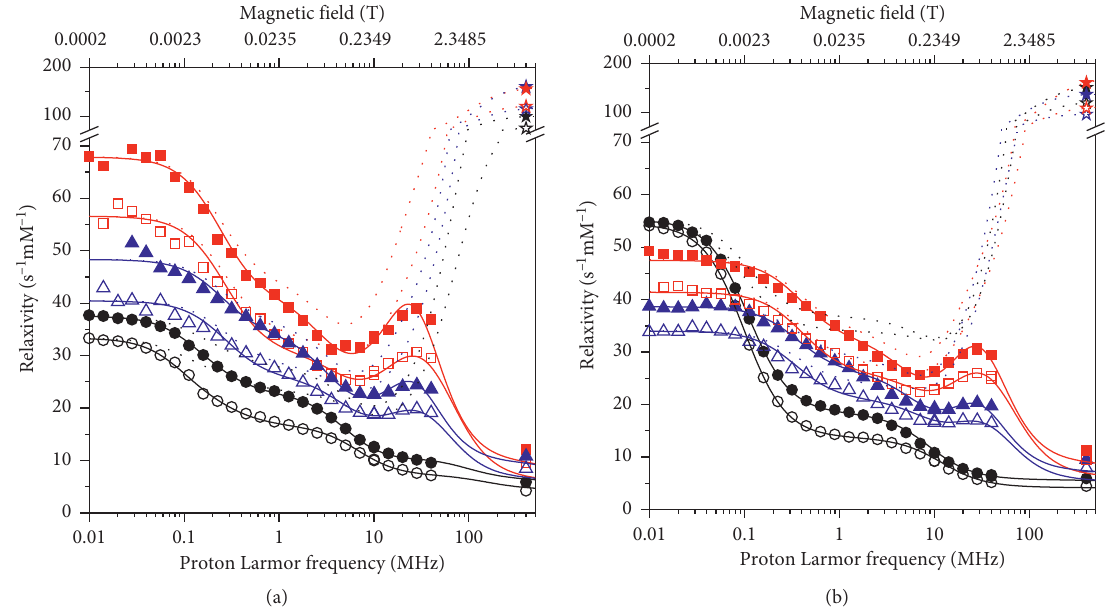
Figure 6: (a) 1 H longitudinal relaxivity profiles and transverse relaxivity at 400 MHz (stars) of Mn 2+ ions in pineapple juice without (black symbols) and with alginate (5%: blue symbols; 15%: red symbols) at 25 ° C (solid symbols) and 37 ° C (empty symbols). (b) 1 H longitudinal relaxivity profiles and transverse relaxivity at 400 MHz (stars) of Mn 2+ solutions without (black symbols) and with alginate (5%: blue symbols; 15%: red symbols) at 25 ° C (solid symbols) and 37 ° C (empty symbols). The solid and dotted lines represent the best fit profiles of the longitudinal and transverse relaxivities,